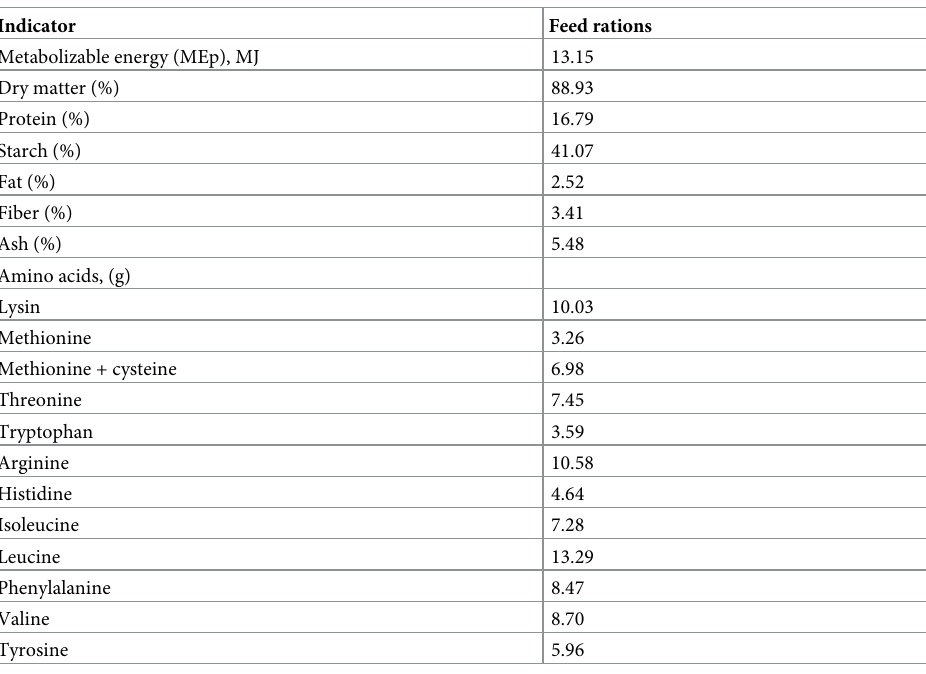
Table 2. Chemical composition of the feed rations (dry matter).